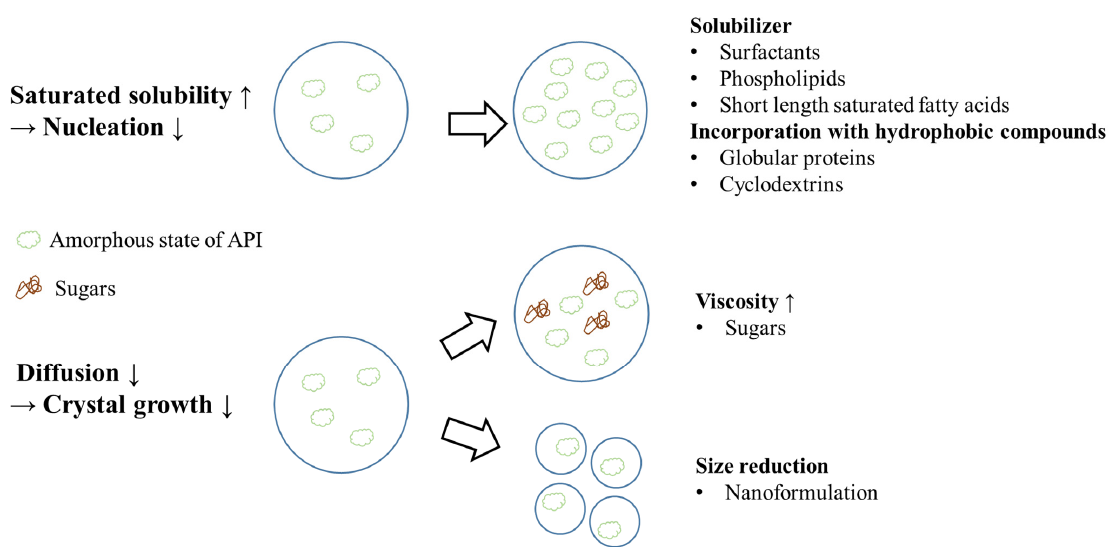
Figure 12. The mechanism of crystallization suppression in a lipid-based